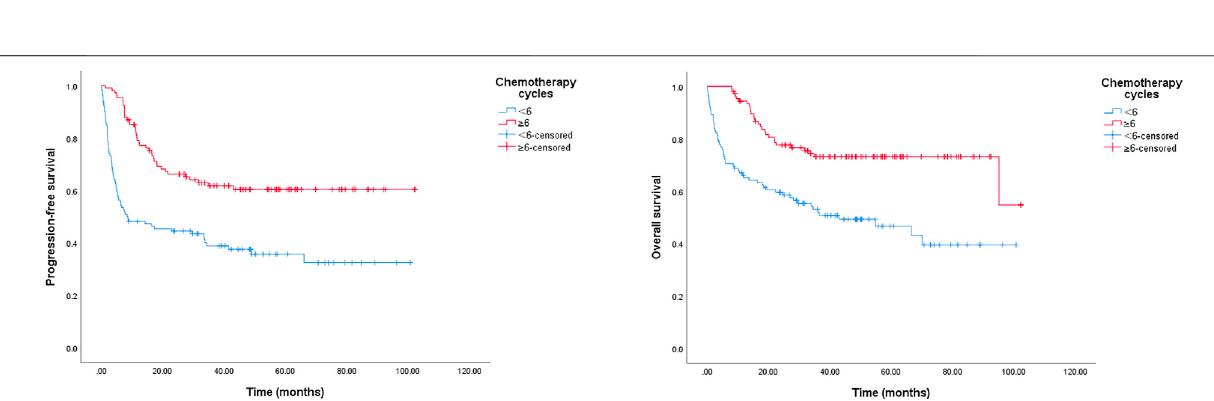
FIGURE4 | Kaplan-Meier survival curve ofPFS and OS forDLBCL patientsstrati fi ed bychemotherapy cycles. The 2-year PFS rates ingroup of < 6 chemotherapy cyclesandingroupof ≥ 6cycleswere44.5%,66.2%, p =0.000;the2-yearOSratesingroupof < 6chemotherapycyclesandingroupof ≥ 6cycleswere59.5%,77.6%, p =